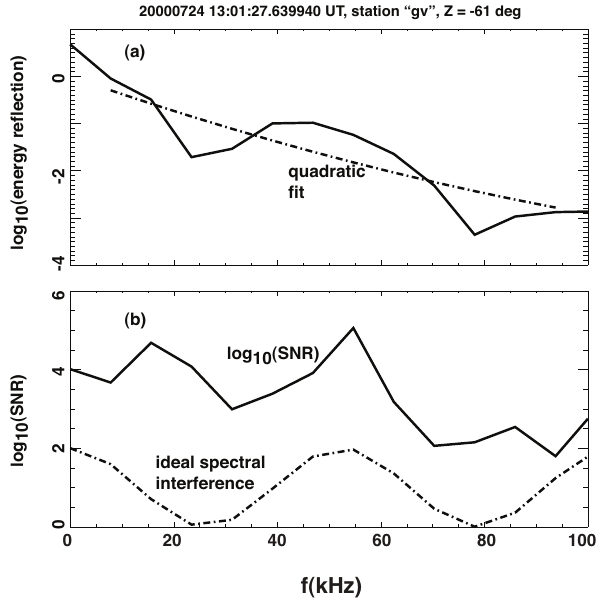
Fig. 4. Frequency-domain analysis of the data of Fig. 3. (a) log 10 (energy reflectivity), uncorrected for dipole lobe shapes, with quadratic fit (dashed curve), (b) log 10 (echo signal-to-noise ratio), with ideal spectral-interference model (dashed